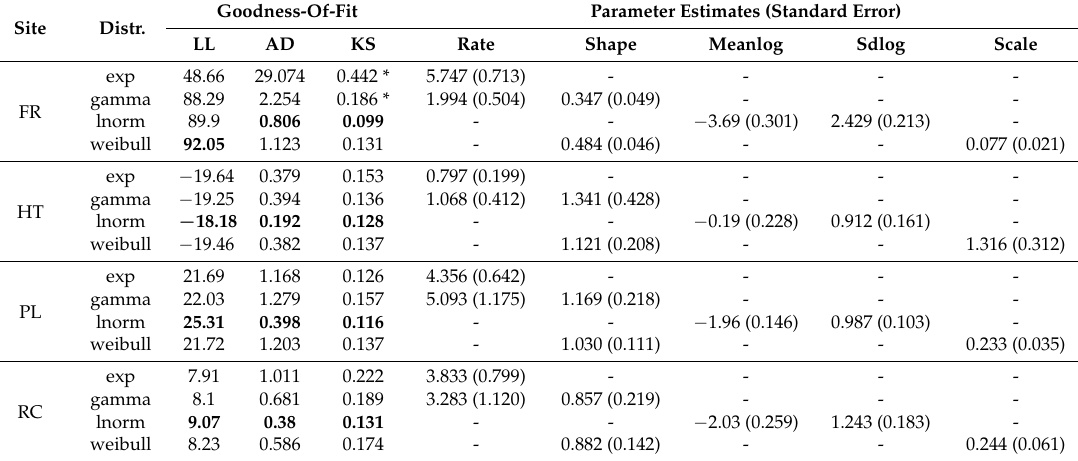
Table 4. Results of fitting empirical TSS load distribution functions to theoretical distribution